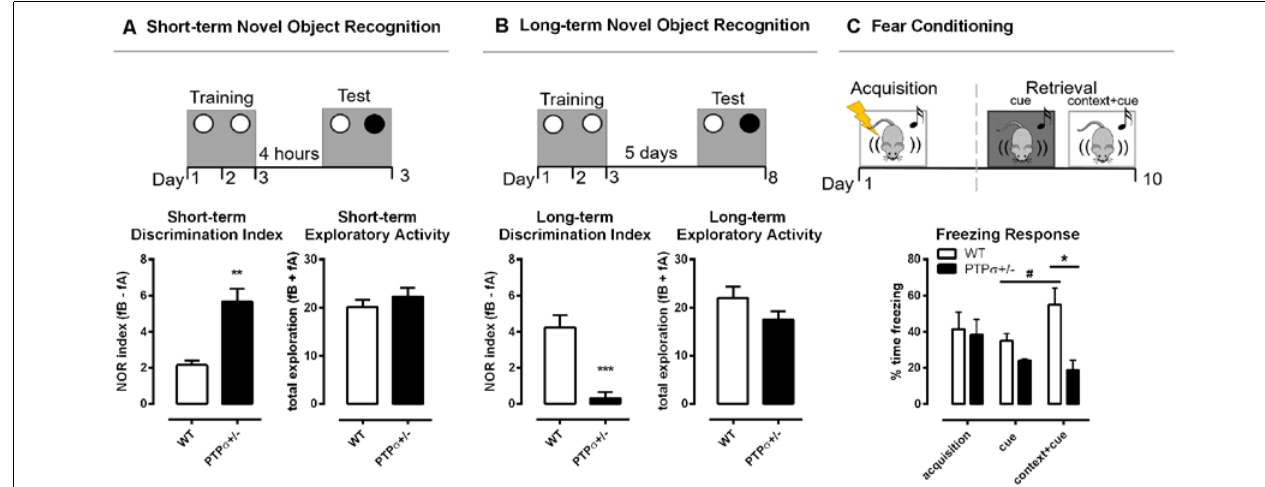
FIGURE 2 | PTP σ + / − mice demonstrate improved short-term but impaired long-term memory. PTP σ + / − mice have (A) improved short-term memory and (B) impaired long-term memory and no changes in the total exploratory activity in the Novel Object Recognition test. (C) The fear response triggered by the cue in the retrieval session was potentiated by the context in WT but not in the PTP σ + / − mice. Data were analyzed by (A,B) Mann–Whitney test, and (C) two-way ANOVA. * p < 0.05, ** p < 0.01, *** p < 0.001. In (C) : # p < 0.05 (vs. WT cue), * p < 0.05 (vs. WT